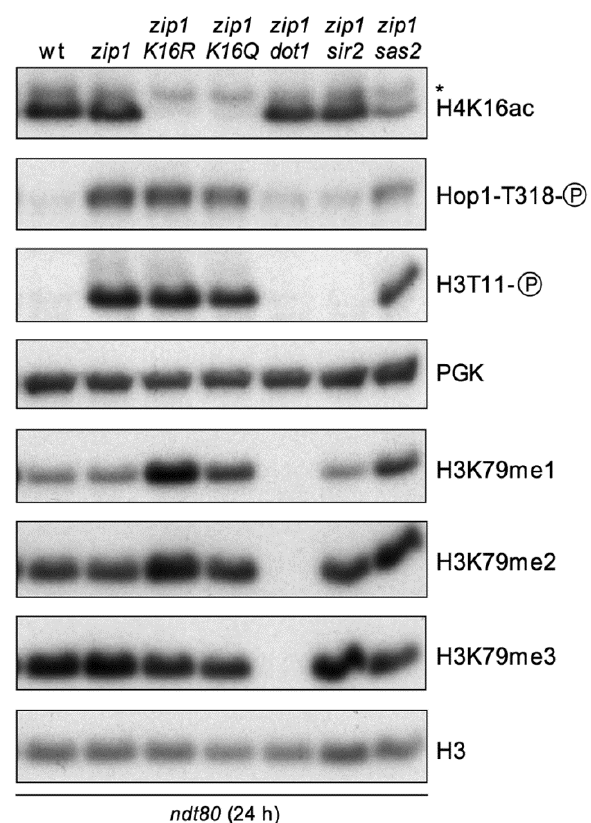
FIGURE 5: The sir2 mutant, but not H4-K16Q , H4-K16R or sas2 , is defective in establishing early markers of checkpoint